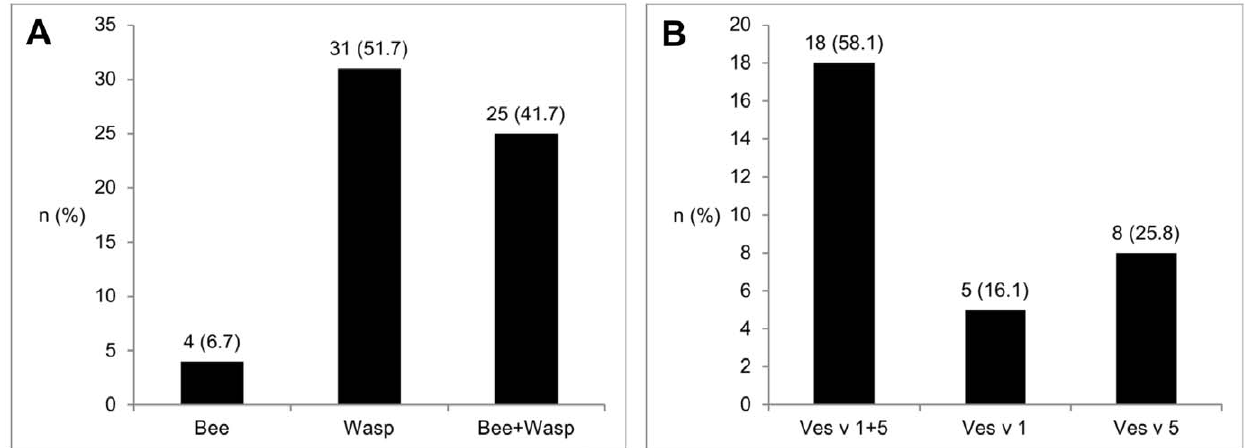
Figure 4. Component resolved diagnosis in CAP double sensitized patients. A Sensitization to bee and/or vespid venom in the component resolved diagnosis . Positive for bee venom: rApi m 1 pos / nVes v 1 neg and nVes v 5 neg ; Positive for wasp venom: rApi m 1 neg / nVes v 1 and/or nVes v 5 pos ; DS: rApi m 1 pos / nVes v 1 and/or nVes v 5 pos . n=60. B Sensitization pattern in vespid venom allergic patients . The majority of patients were sensitized to both vespid major allergens (nVes v 1 and nVes v 5). Nevertheless, a considerable proportion had a mono sensitization to nVes v 1 or nVes v 5. n=31.